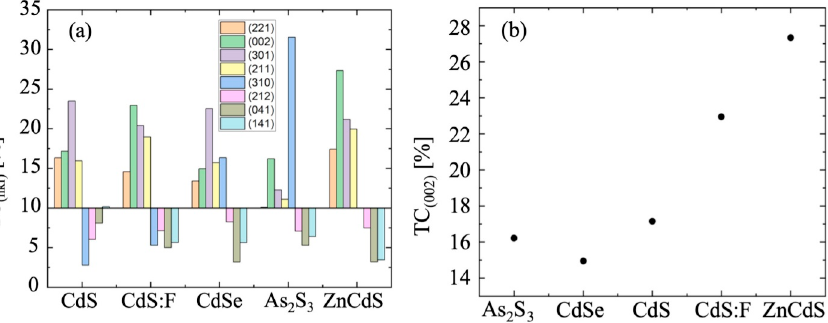
Figure 5. ( a ) Texture coefficient for different crystalline planes; histograms under the 10% line have to be considered as negative values with respect to 10%; ( b ) Trend of the texture coefficient of the (002) plane as a function of different window